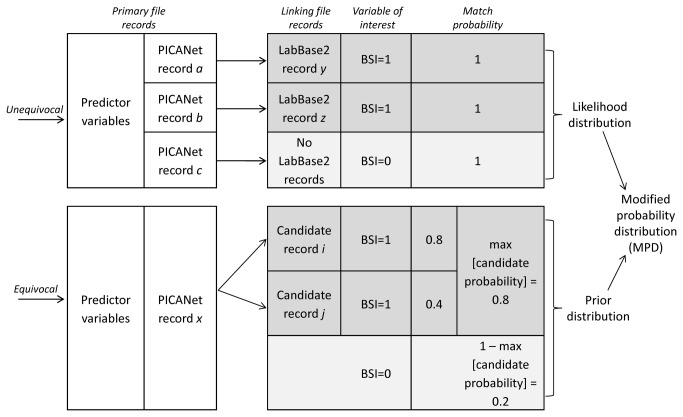
Prior-informed imputation for ‘incomplete’ linkage between PICANet and LabBase2.Predictor variables: Length of stay, age, admission type, admission source, renal status, quarter-year at admission.